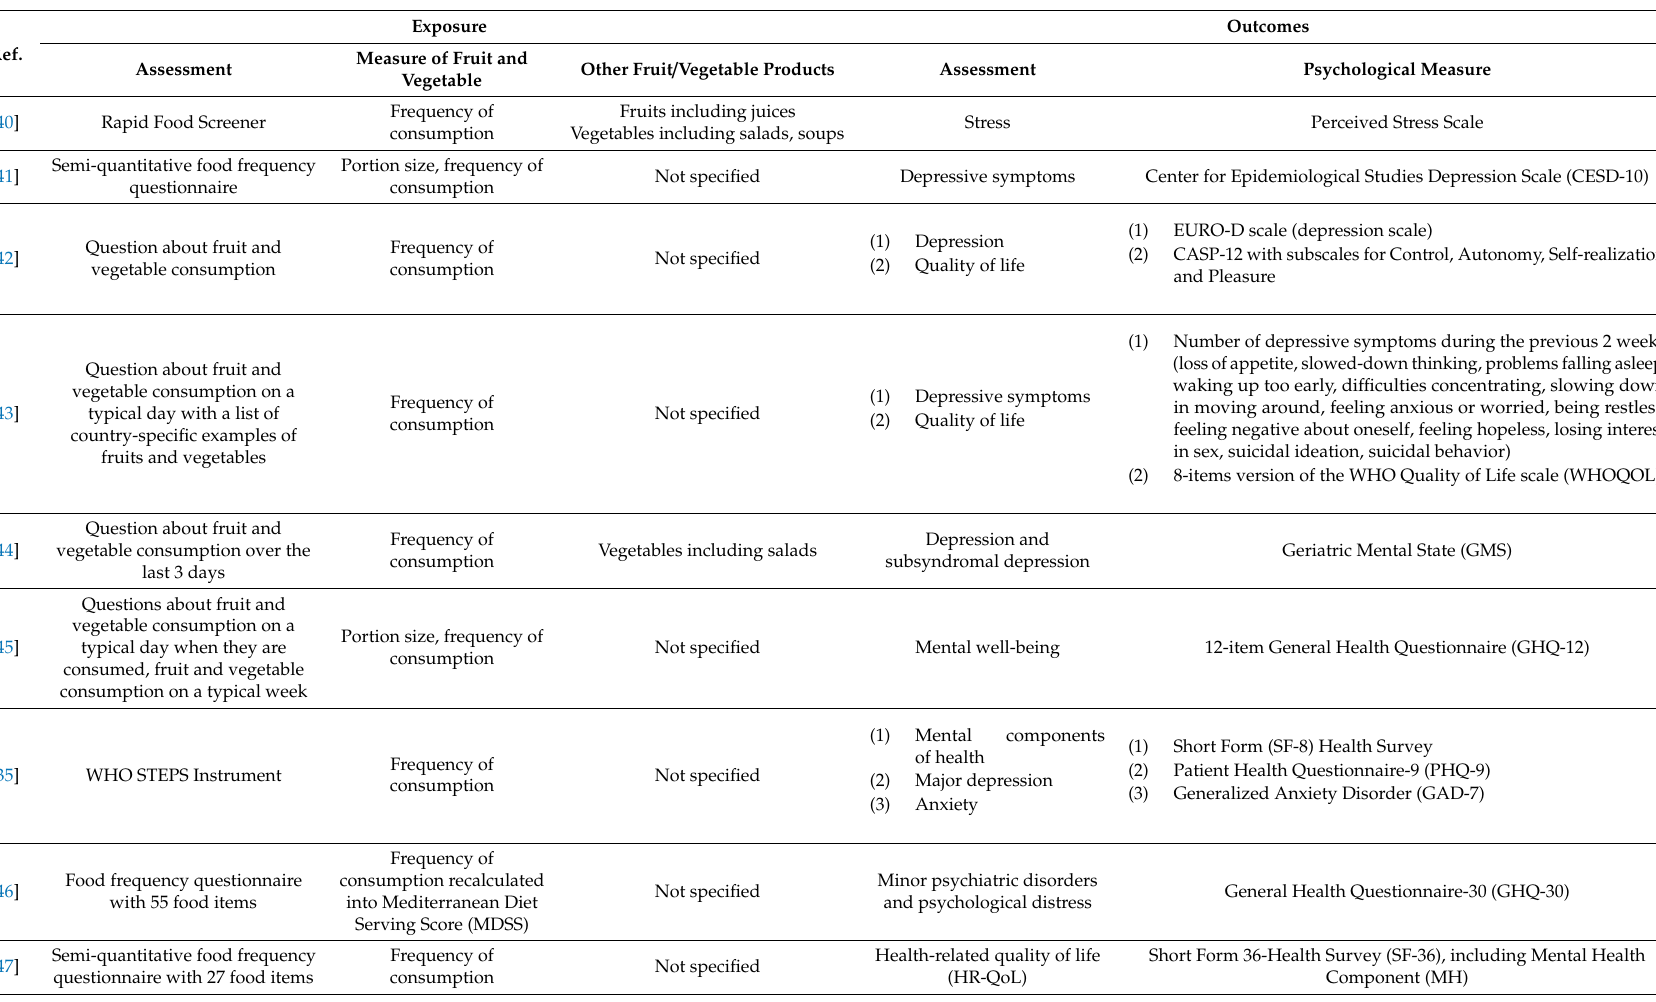
Table 2. Characteristics of the study exposure and outcomes for the studies included to the systematic